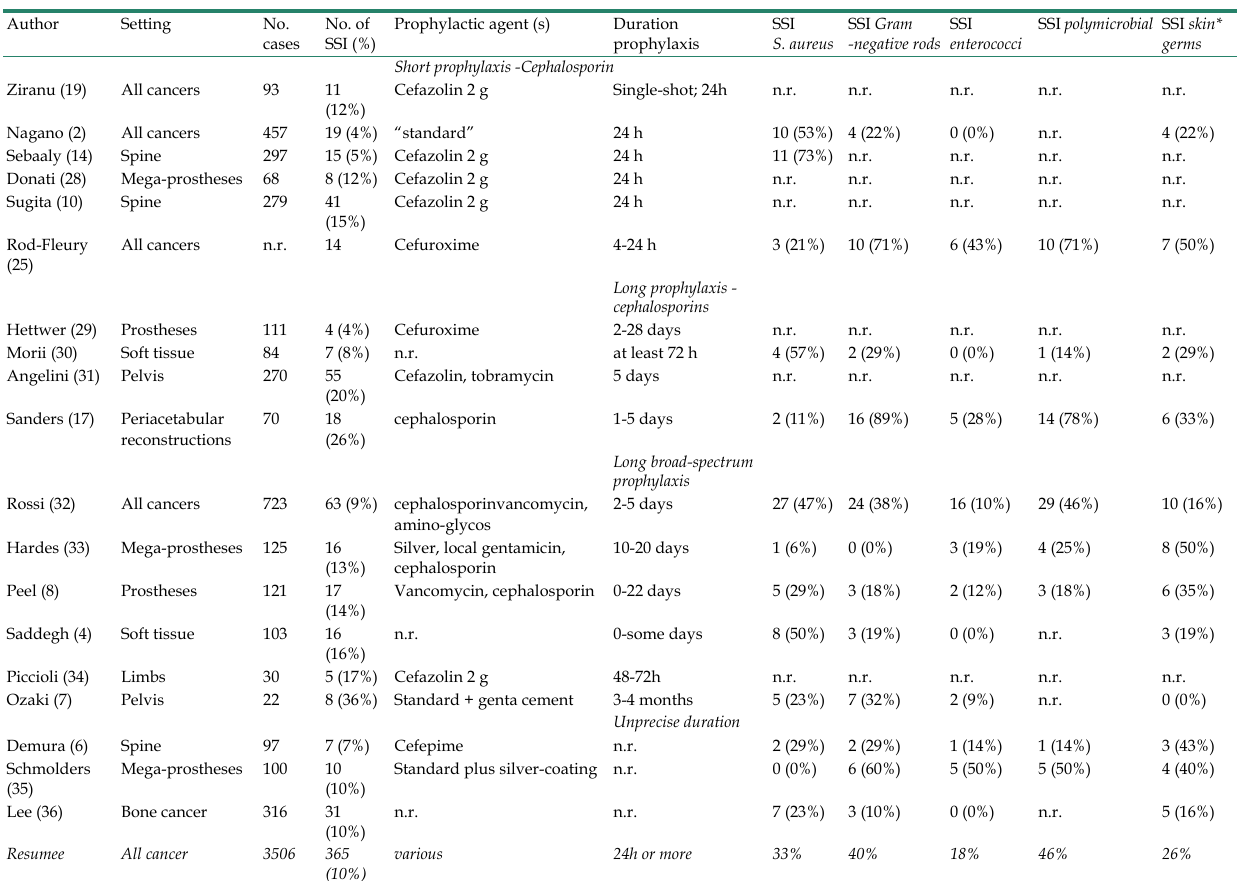
Table 1. Prophylaxis of surgical site infections (SSI) in orthopaedic cancer surgery (selected literature)